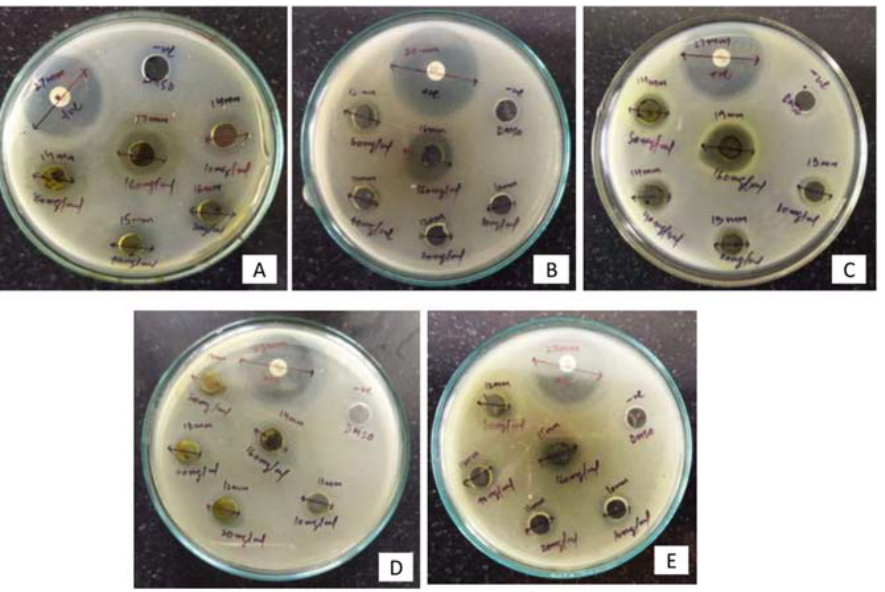
Figure 2. The inhibition zones (mm) of methanol leaf extract of Skimmia anquetilia against ( A ) Escherichia coli ( B ) Pseudomonas aeruginosa ( C ) Klebsiella pneumoniae ( D ) Salmonella typhi , and ( E ) Staphylococcus aureus . Table 3. In - vitro antibacterial activity and MIC of S. anquetilia methanol leaf extract against tested bacterial strains.